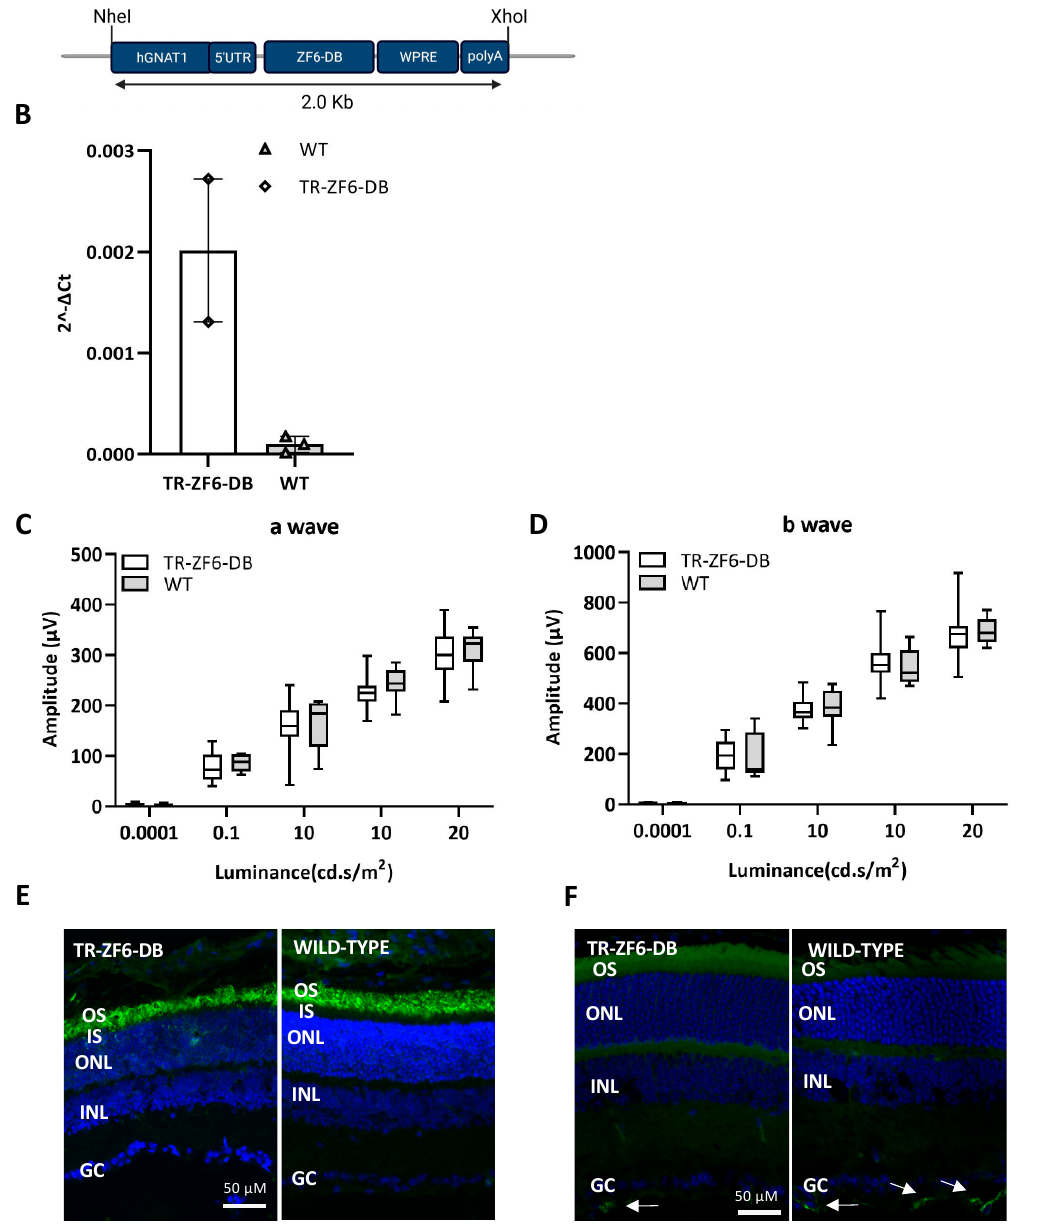
Figure 2. Transgenic mice expressing the ZF6-DB (TR-ZF6-DB) transcriptional repressor in the murine retina. ( A ) representation of TR-ZF6-DB transgenic construct showing the human Guanine Nucleotide Binding Protein1 (hGNAT1) promoter fragment including the 5 ′ UTR cloned upstream the ZF6-DB coding sequence followed by the WPRE and the bovine growth hormone polyA (bGH). ( B ) qReal Time PCR of mRNA expression levels (2 −∆ CT ) of the ZF6-DB transgene on postnatal day 10 (P10) retina compared to wild-type match controls. TR-ZF6-DB, n = 4 (2 littermate pups belonging to two independent TR-ZF6-DB F0 litter (4 pulled retina); WT n = 6 (2 littermate pups (4 pulled retina) from the same litter). ( C , D ) a- and b-waves amplitudes recorded in scotopic conditions plotted as a function of light intensity (log cd * s/m 2 ) in one-month old TR-ZF6-DB ( n = 4, white box) and WT controls ( n = 4, controls CTR grey box). Statistics: t -test corrected with Holm–Sidak method for multiple comparisons. ( E ) Rho immunofluorescence (green) histological analysis of one-month old TR-ZF6-DB and WT controls. ( F ) Glia-derived neurotrophic factor (GFAP) immunofluorescence (green) histological analysis of one-month old TR-ZF6-DB and WT controls. Arrows indicate positive in the ganglion cell layer, GC. OS, Outer Segment. IS, Inner Segment. ONL, Outer nuclear Layer. INL, Inner Nuclear Layer.